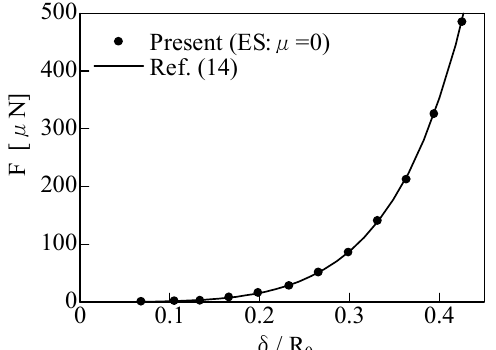
Fig.3 Comparison of the calculation results ( h = 7.75µm)